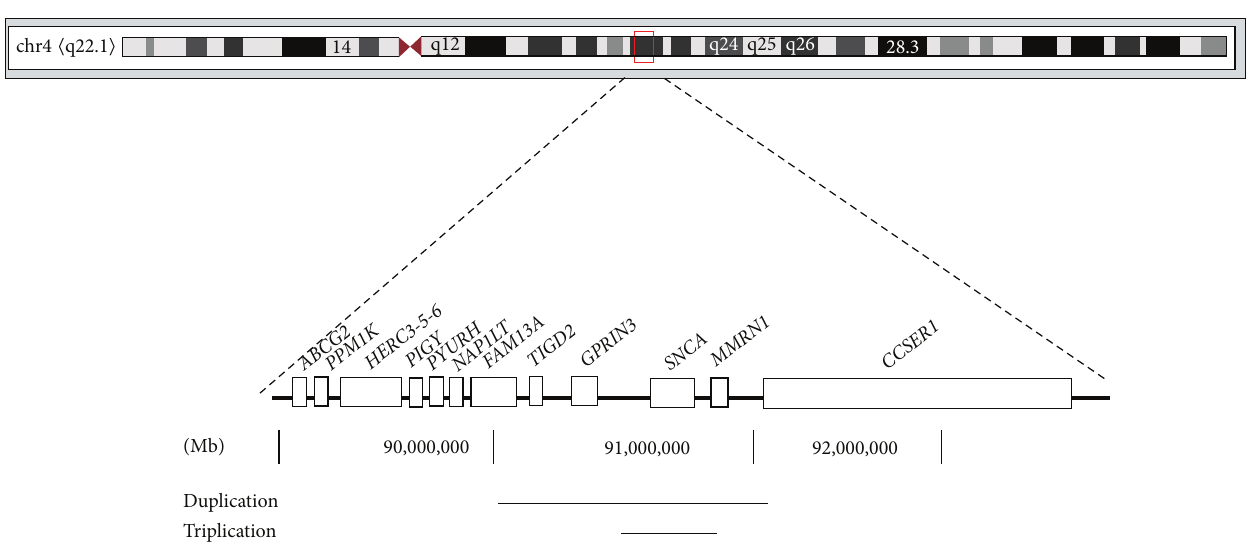
Figure 3: Schematic representation of the multiplication described on chromosome 4, consisting of a 351 Kb triplication of a locus containing SNCA and 6 exons of MMRN1 gene (90.500.031 Mb to 90.851.296 Mb) and a duplication of 1,29 Mb of a genomic region flanking the triplication, involving TIGD2 , GPRIN3 , SNCA , and MMRN1 and from exon 1 to exon 3 of CCSER1 (90.013.153 Mb to 91.310.633 Mb). Scale is expressed in Megabases